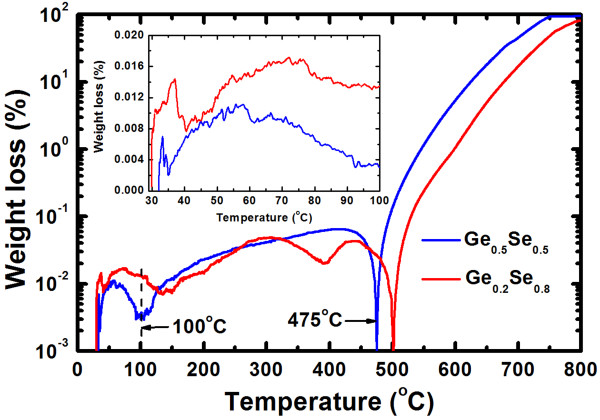
Weight loss of the Ge0.5Se0.5and Ge0.2Se0.8switching materials. The Ge0.5Se0.5 material shows lower loss below 100°C, indicating that a higher Ge content enhances thermal stability.